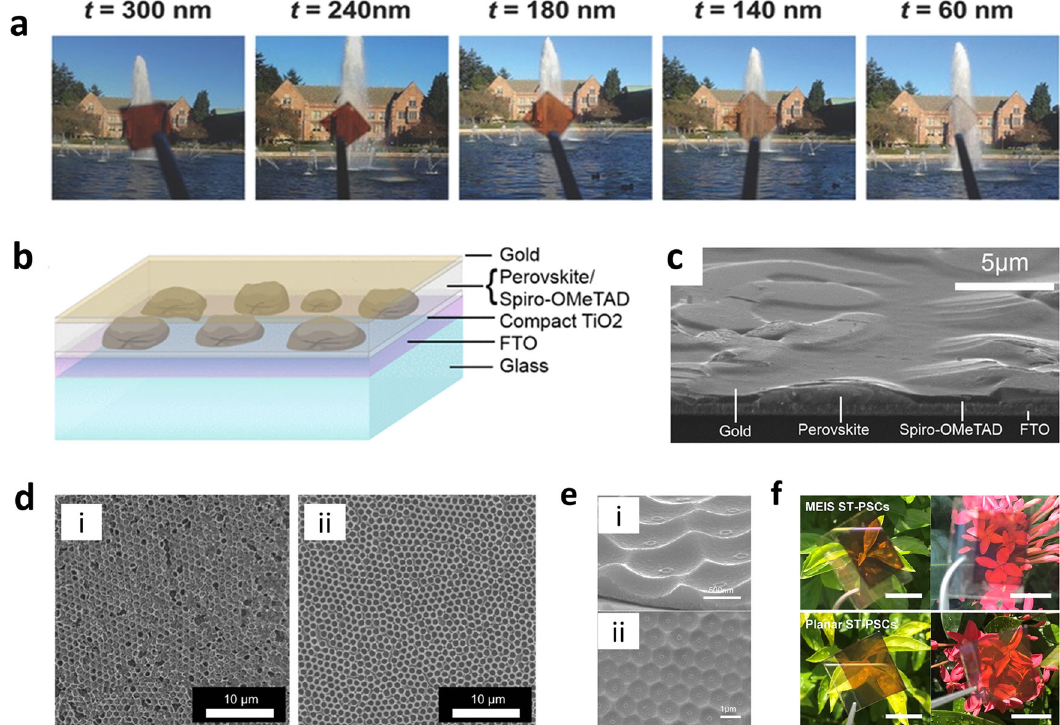
Fig. 6 Semitransparent perovskite solar cells. a Photographs of CH 3 NH 3 PbI 3 fi lms with different thicknesses on CuSCN treated ITO-coated glass substrates. a Adapted with permission from ref. 110 , Copyright 2015 Wiley-VCH. b A layered structure of the dewetting strategy applied to a PSC. c Cross- sectional SEM image of a neutral colored semitransparent device. b , c Adapted with permission from ref. 111 , Copyright 2014 American Chemical Society. d SEM images of perovskite fi lm formations within (i) TiO 2 and (ii) SiO 2 honeycomb scaffolds. d Adapted with permission from ref. 113 , Copyright 2015 Royal Society of Chemistry. e (i) Tilted-view and (ii) top-view SEM images of MEIS-ITO. f Photographs of planar (reference) and MEIS based semitransparent PSCs. e , f adapted with permission from ref. 114 , Copyright 2021